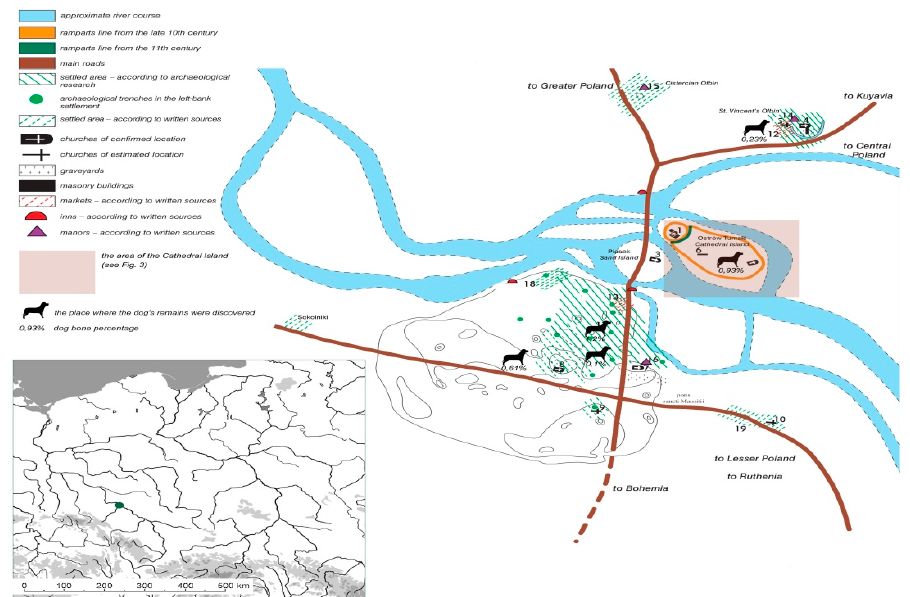
Figure 4. Wroclaw on the map of Poland and the early medieval settlement complex in Wroclaw around 1200 AD, according to [37]. Reproduced with permission from J. Pieklaski, C. Bu ś ko, and J. Po ł amarczuk, the Historical Atlas of Polish Towns: Wroclaw; published by Instytut Archeologii i Etnologii PAN, 2017 (with modifications by A. Pankiewicz).